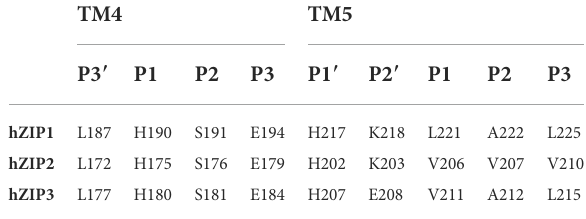
TABLE 6 Subgroup II TM4 and TM5 BMC residues.